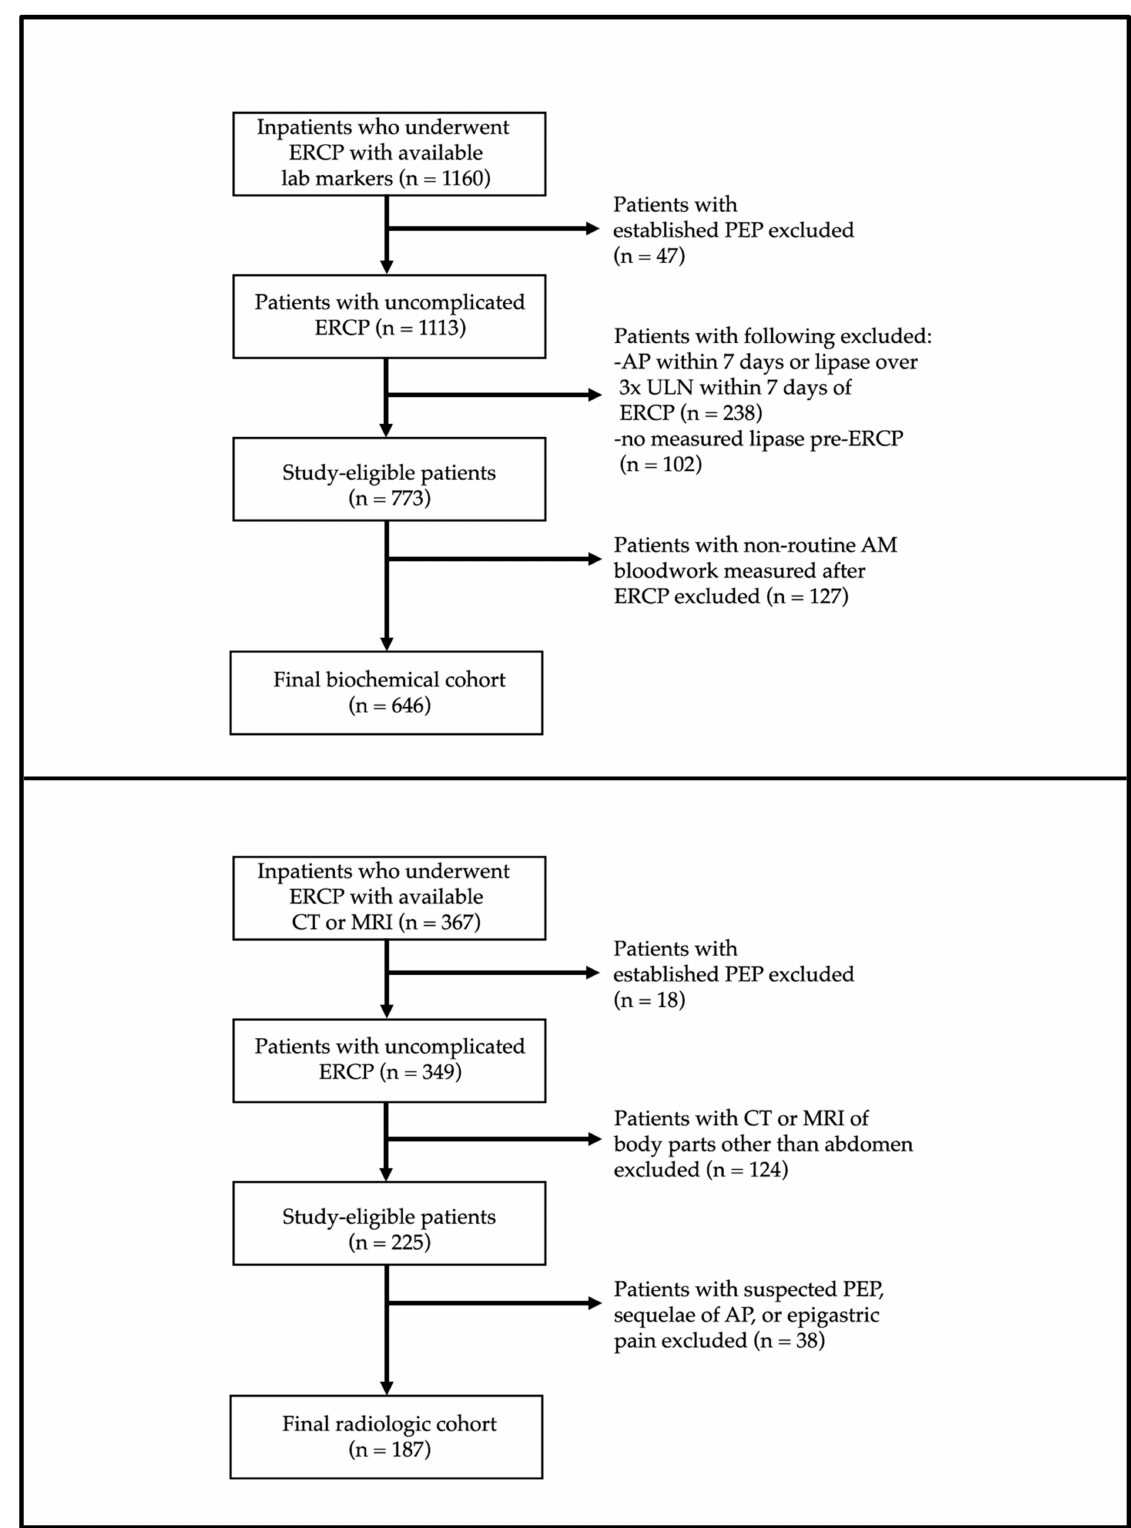
Figure 1. Study flowchart with exclusions for biochemical and radiologic